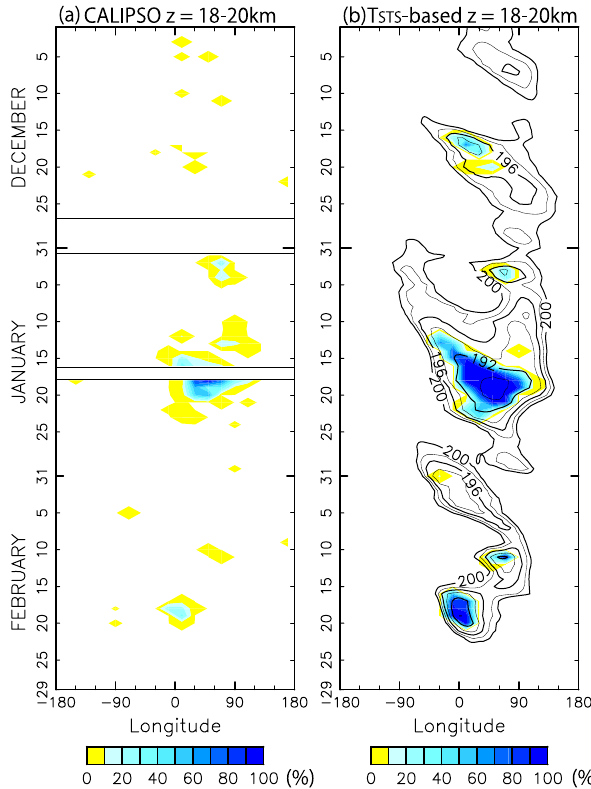
Fig. 14. The same as Fig. 3 but for the latitude range of 65 ◦ N– 70 ◦ N in the winter of